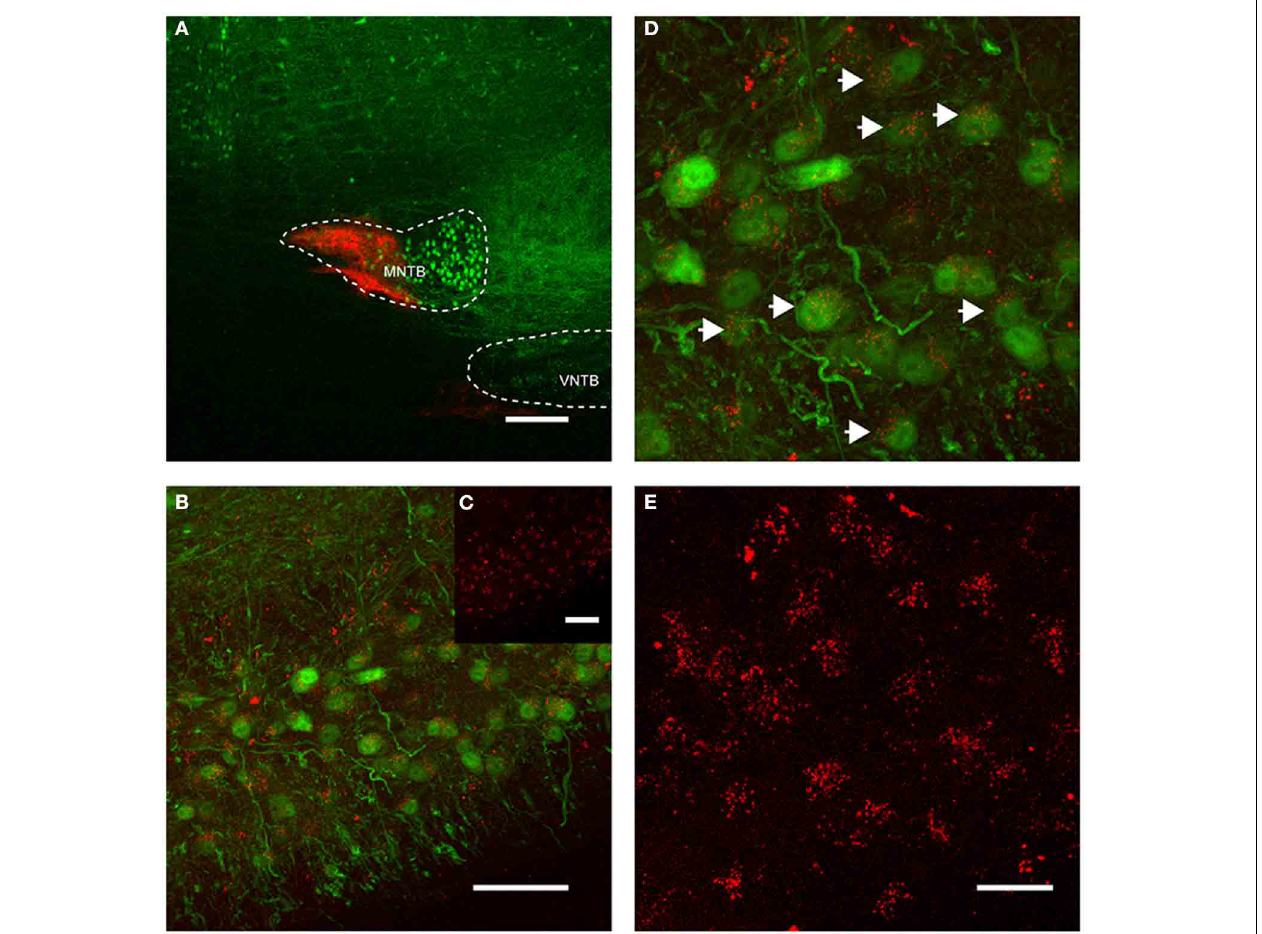
FIGURE 4 | Retrograde labeling of MNTB resulted in labeling of glycinergic neurons in the ipsilateral VNTB. The image is from a case in which CTB was injected into the MNTB of a p88 GlyT2-GFP mouse. Glycinergic neurons expressing GFP are shown in green, the tracer is shown in red. (A) Shows the site of injection targeting mostly the medial half of the MNTB. (B) Depicts the resulting label in the ipsilateral